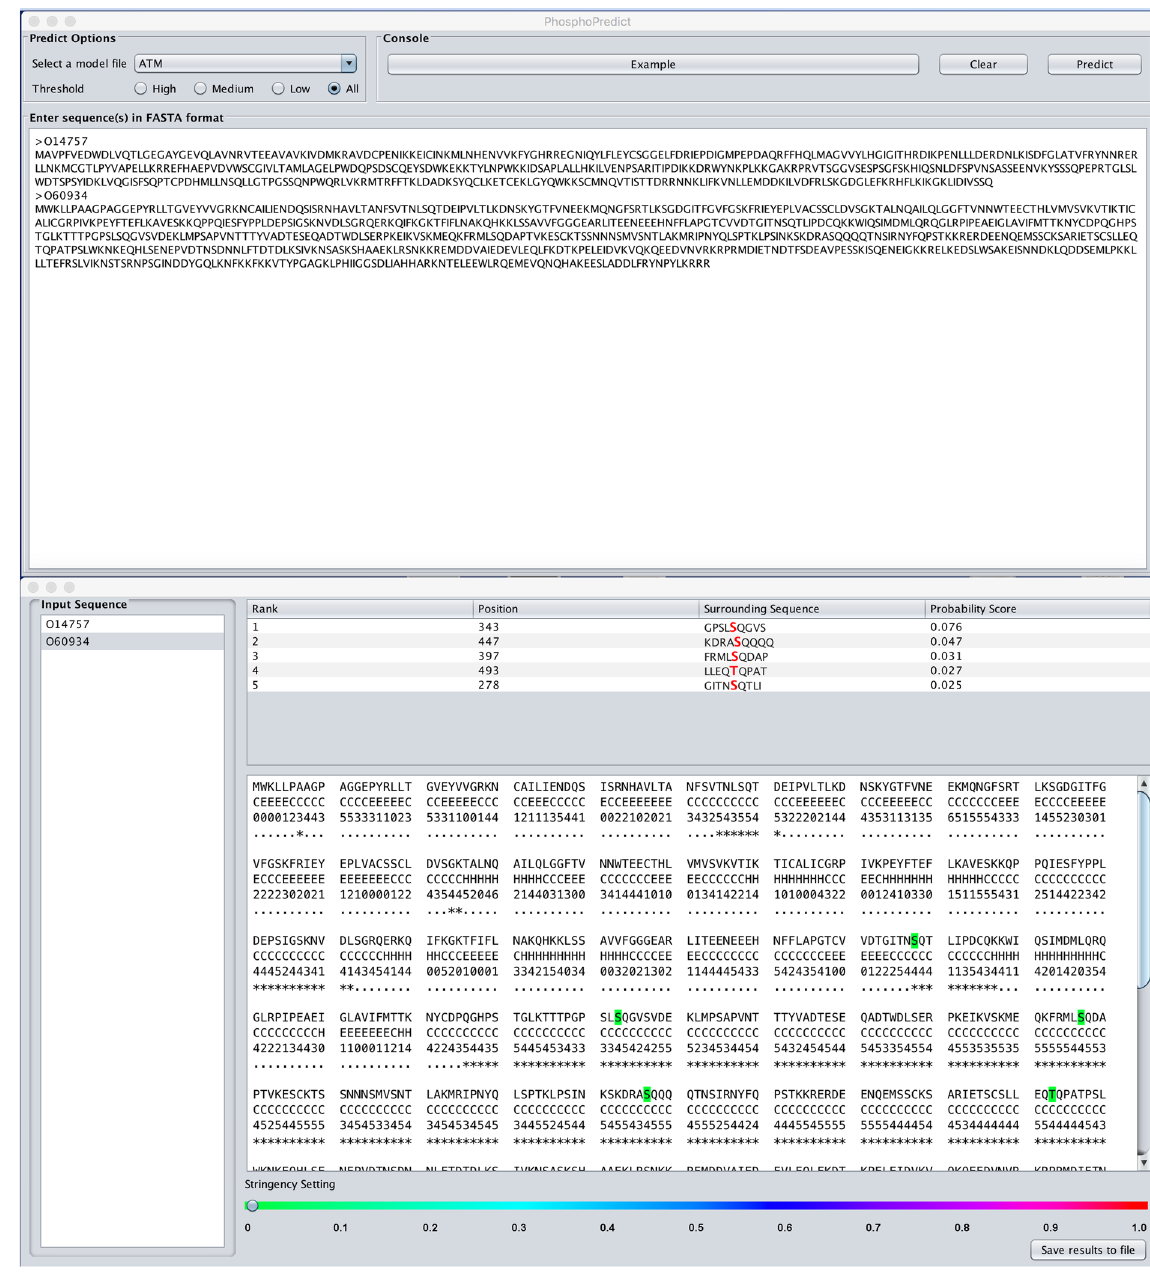
Figure 6. Example output of the PhosphoPredict Java application. Predicted phosphorylation sites of the cell cycle regulatory protein p95 (Nibrin, Uniprot ID: O60934) by the ATM kinase are